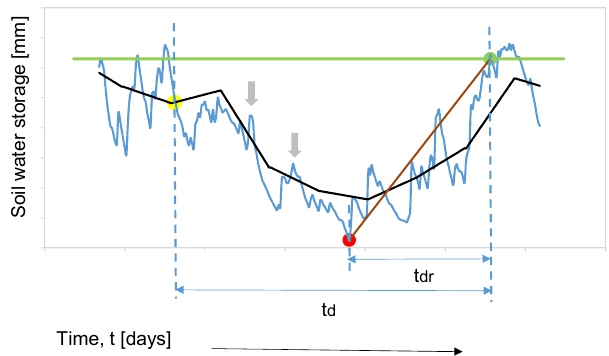
Figure 2. Conceptual diagram for the estimation of the soil mois- ture drought recovery metrics. t d and t dr are the durations of the soil moisture drought event and drought recovery period respectively. The drought recovery is represented by a brown line. The grey ar- rows mark intermittent events above the threshold. The green line marks the assumed normal value of the soil water